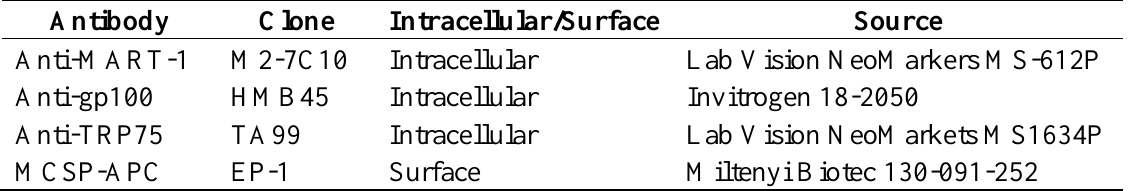
Table 6. Antibodies used for staining, their characteristics and